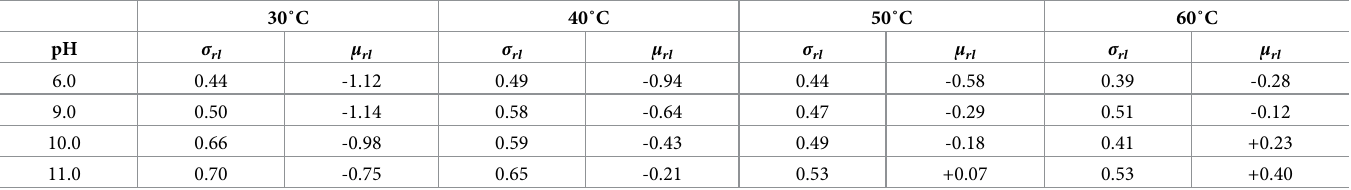
Table 1. Calculated σ and μ obtained from cleaning test of hemoglobin-soiled cloth with respect to various temperature and pH rl rl